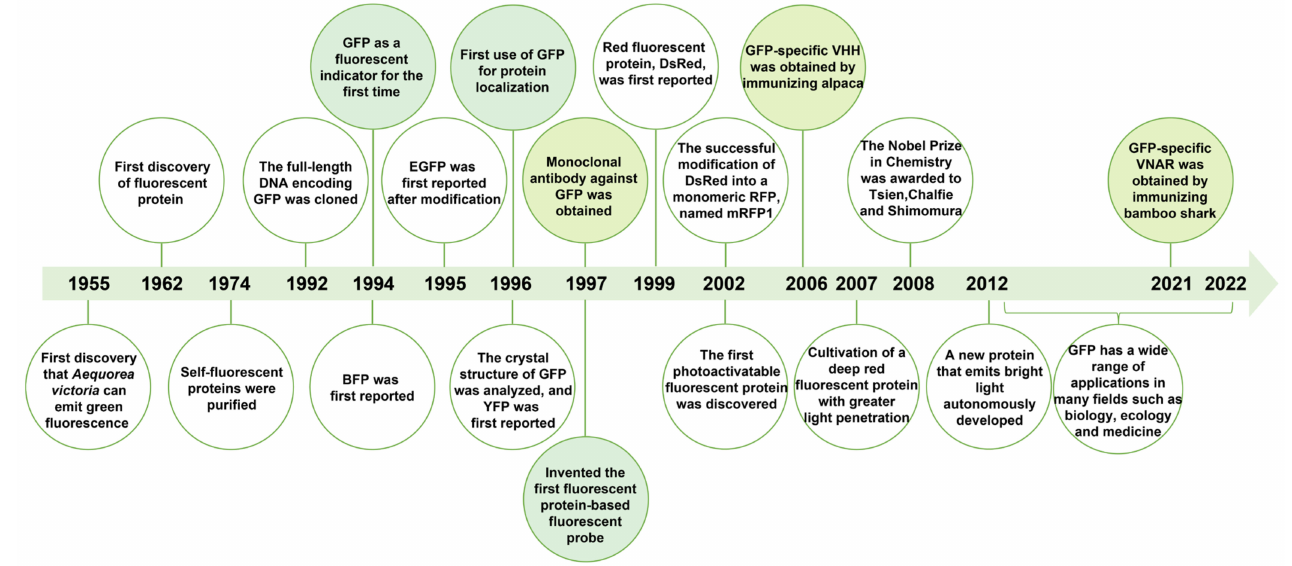
Figure 2. The development of fluorescent proteins. GFP, green fluorescent protein; BFP, blue fluo- rescent protein; EGFP, enhanced green fluorescent protein; YFP, yellow fluorescent protein; RFP, red fluorescent protein; VHH, variable domain of heavy chain; VNAR, variable new antigen receptor. The pale green marker indicates the progress of research on GFP application and the yellow green marker indicates the progress of research on GFP